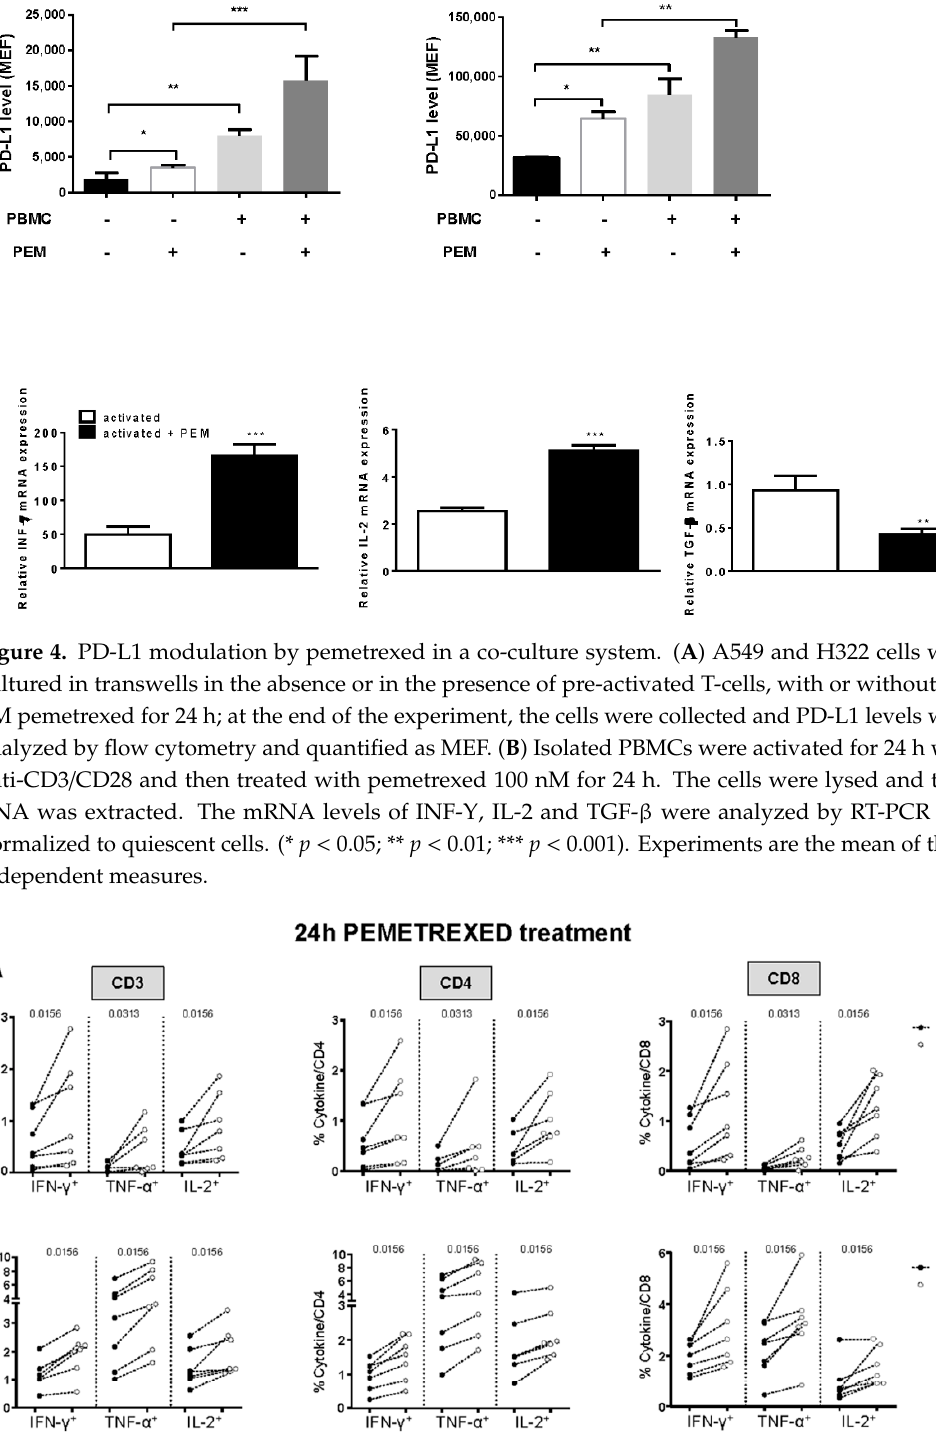
Figure 5. In vitro pemetrexed treatment improved T-cell responses. ( A ) PBMCs from healthy donors ( n = 7) were stimulated for 24 h with anti-CD3/anti-CD28 antibodies in the presence or absence of 100 nM pemetrexed. This was followed by co-staining for CD3, CD4, or CD8 plus IFN- γ , TNF- α , or IL-2 to determine T-cell function by flow cytometry. Upper and lower plots show results from unstimulated and stimulated PBMCs, respectively, with and without 24 h pemetrexed treatment.